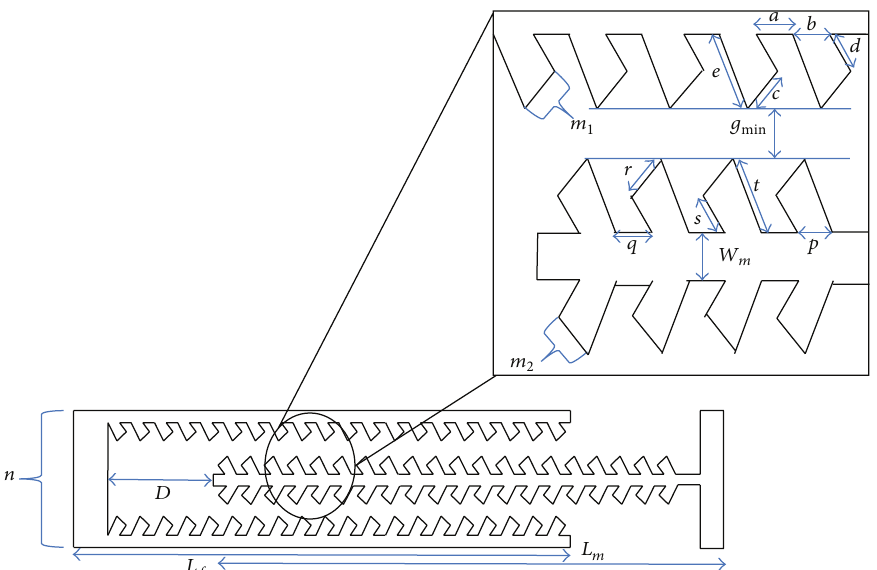
Figure 3: A schematic cross-sectional view of an example of single finger [𝑛 = 1] of fishbone electrostatic comb driver having 20 sets of small fingers [ 𝑚 1 , 𝑚 2 = 20] within and a portion of single unit fishbone electrostatic comb driver.